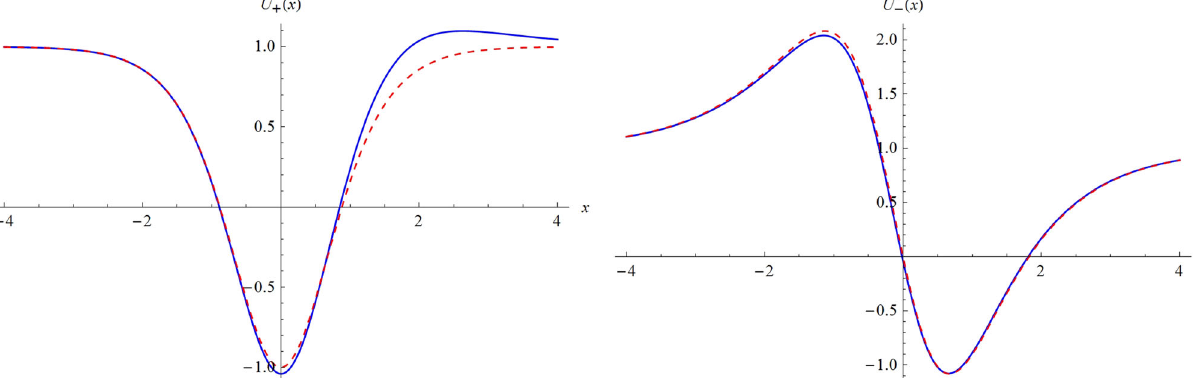
Fig. 12 Quantum-mechanical potentials U + (on the left) and U − (on the right) for α = β = 1. For both, we have plotted the values c 1 = 0 (dashed red lines) and c 1 = 0 . 02 (blue solid